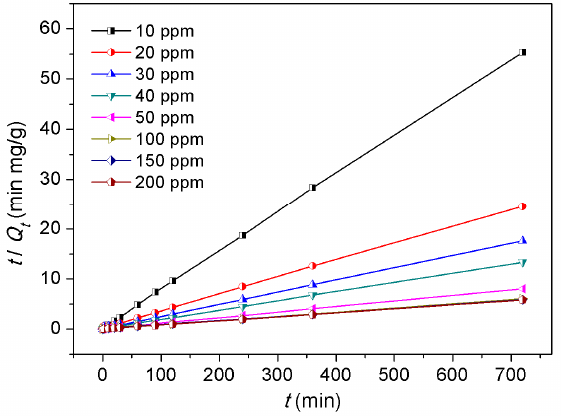
Figure 5. Plots of pseudo-second-order kinetics for the adsorption of MyB over adsorbent 1 .